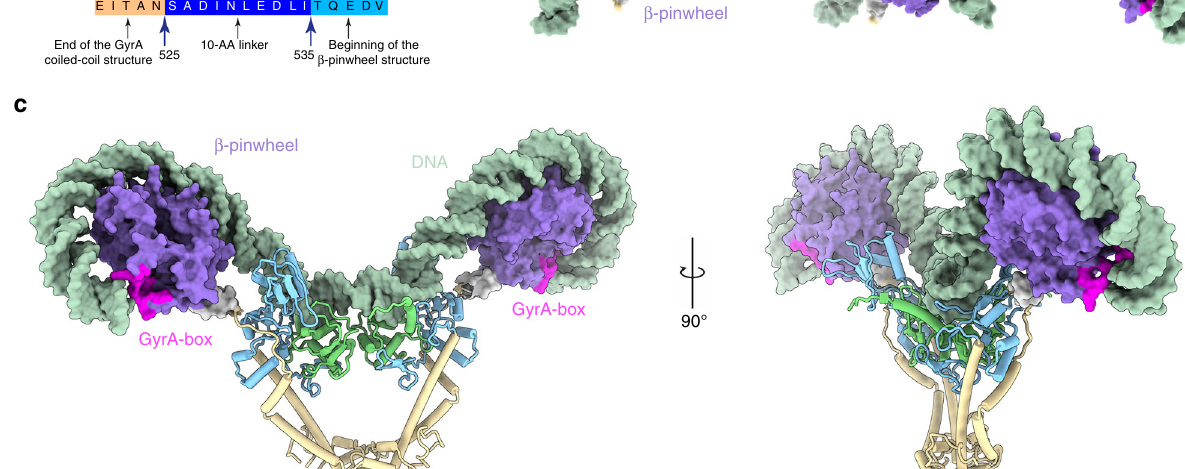
Fig. 10d). State 1 and 2 correspond to a conformational oscillation before the opening of the DNA-gate (Supplementary Movie 2).